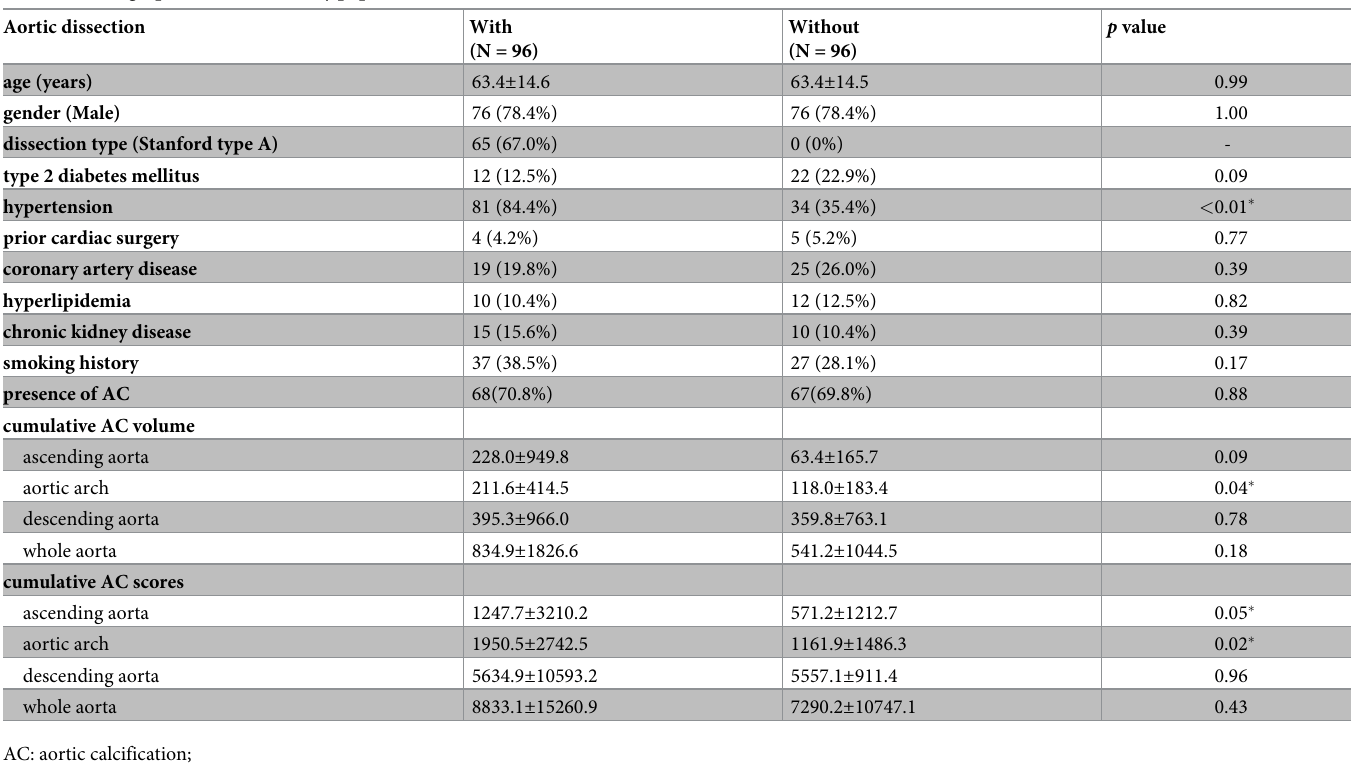
Table 1. Demographic data of the study population.